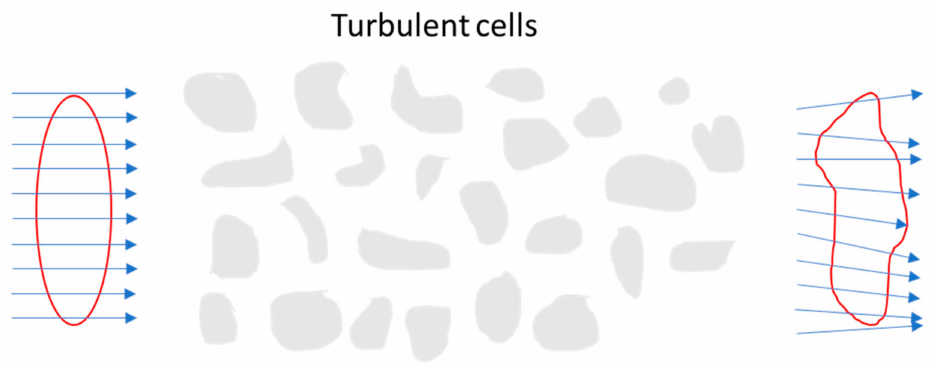
Figure 21. Beam intensity profile is distorted by turbulent cells smaller than the beam diameter. Adapted from